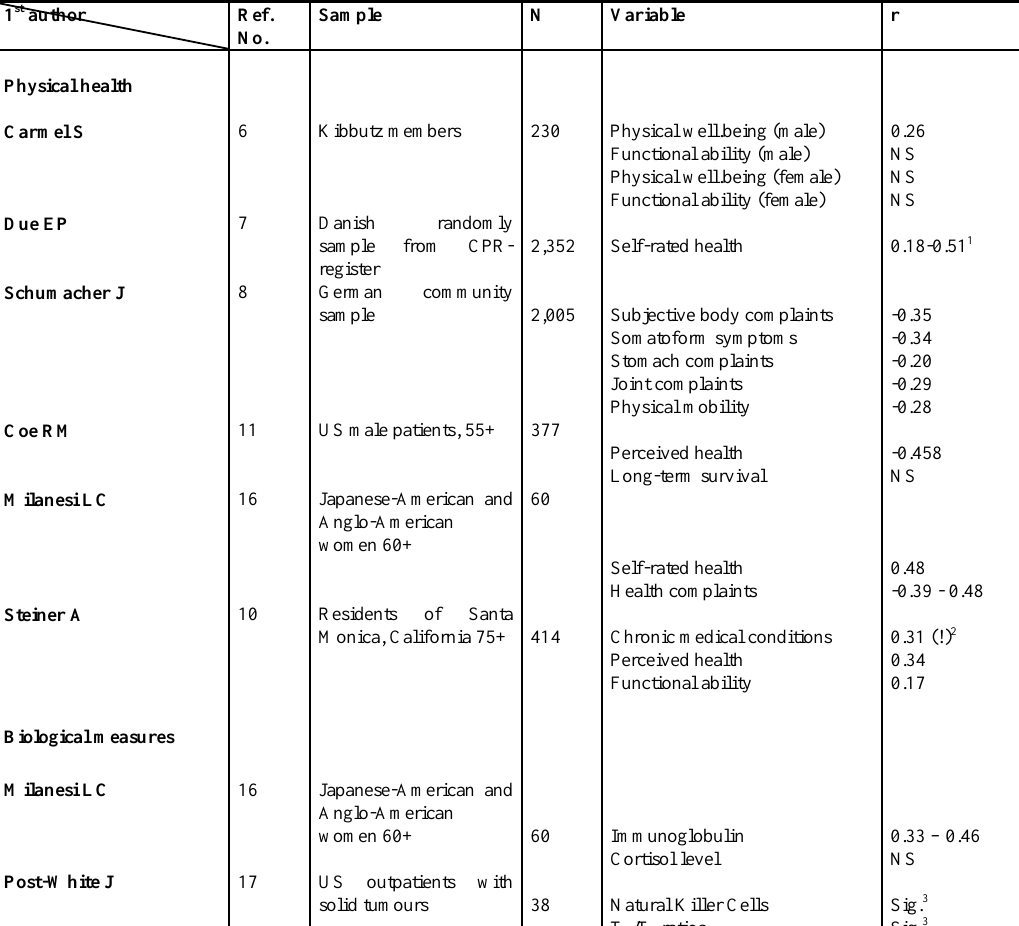
Correlations of SOC (SOC-29 or SOC-13) with physical health and biological measures